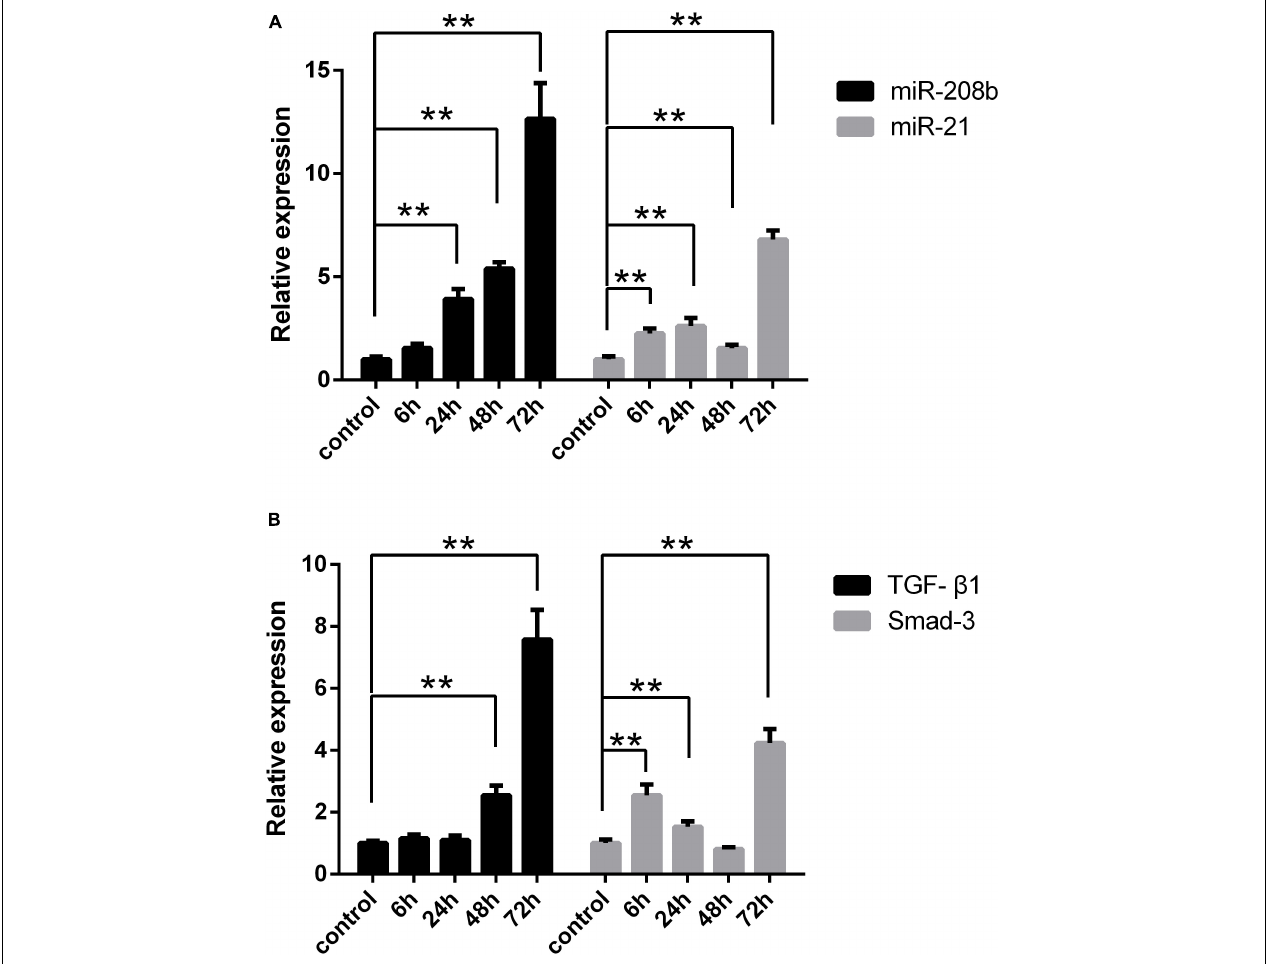
FIGURE 2 | Comparison of the expression of each index under different hypoxia conditions in vitro . (A) Expression of miR-208b and miR-21 in the hypoxic treatment group at 6 h, 24 h, 48 h, and 72 h detected by RT-qPCR; (B) expression of TGF- β 1 and Smad-3 in the hypoxic treatment group at 6 h, 24 h, 48 h, and 72 h detected by RT-qPCR. RT-qPCR, reverse transcription-quantitative polymerase chain reaction; TGF- β 1, transforming growth factor- β 1; * P < 0.05 compared with the control; ** P < 0.01 compared with the